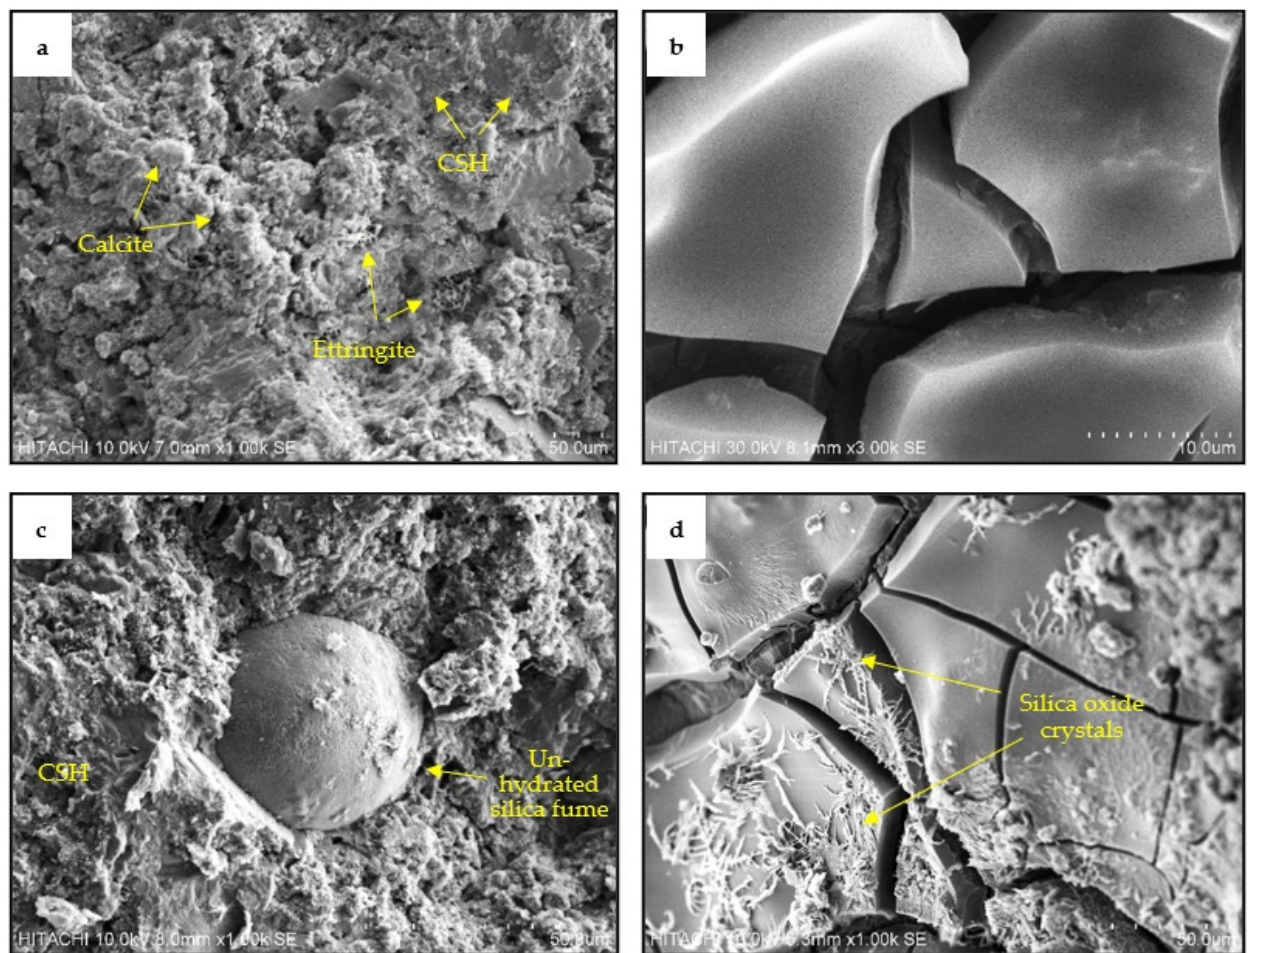
Figure 12. Development of healing compounds at 7 days for both 100%OPC (up) and 95%OPC + 5%SF (down). 100%OPC cement paste at the age of 7 days ( a ) without capsule, and ( b ) with capsules 95%OPC + 5%SF cement paste at the age of 7 days ( c ) without capsule, and ( d ) with capsules.